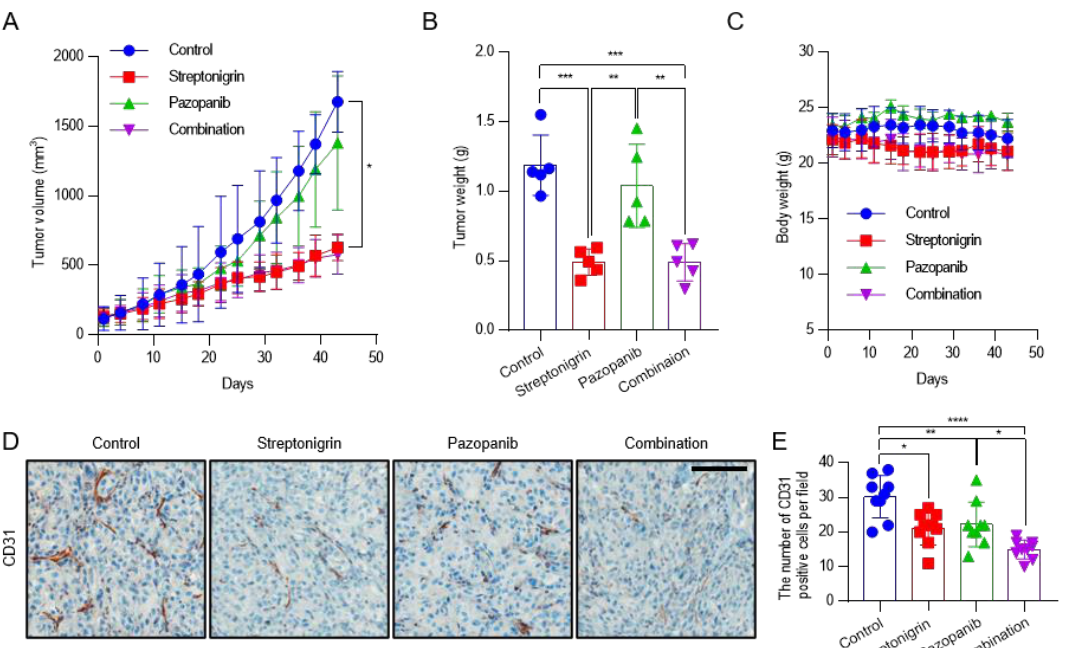
Figure 5. Antitumor activity of pazopanib in combination with TGase 2 inhibition against a CAKI-1 xenograft mouse model. After the subcutaneous injection of CAKI-1 cells (5 × 10 6 cells), mice were randomized into four groups ( n = 5) and were treated with vehicle (control), streptonigrin (0.1 mg / kg), or pazopanib (100 mg / kg) as single agents or in combination. Drugs were administered 3 times a week every other day. ( A ) Tumor growth curves during the treatment period. Each point is the mean tumor volume in the group. ( B ) Tumors were isolated from the mice and weighed. ( C ) Body weights of mice during the treatment period. Each point is the mean weight of mice in each group. ( D ) Representative areas of CD31 IHC staining slides in CAKI-1 tumor xenograft from mice. ( E ) Average number of CD31-positive cells in CAKI-1 tumor xenograft from mice ( n = 9). Error bar represent SD. GraphPad